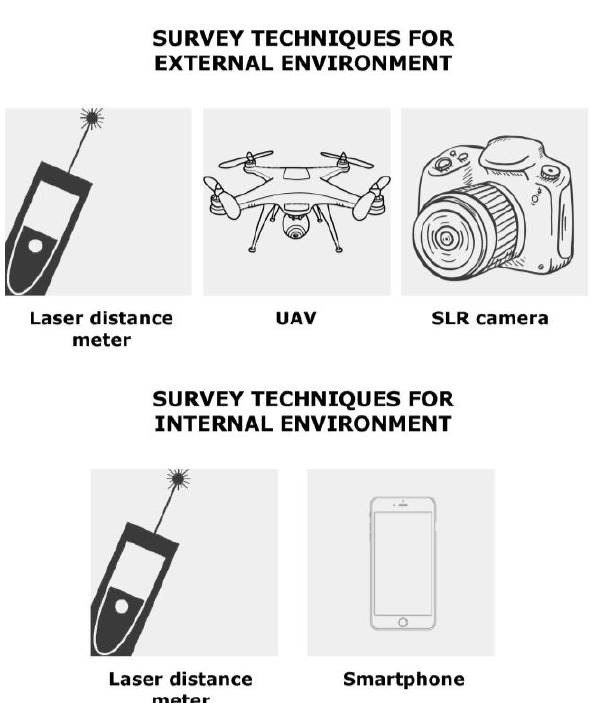
Figure 4. The different techniques followed during survey